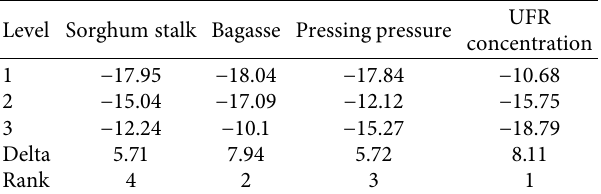
Table 11: Response for means of Moisture Content (MC